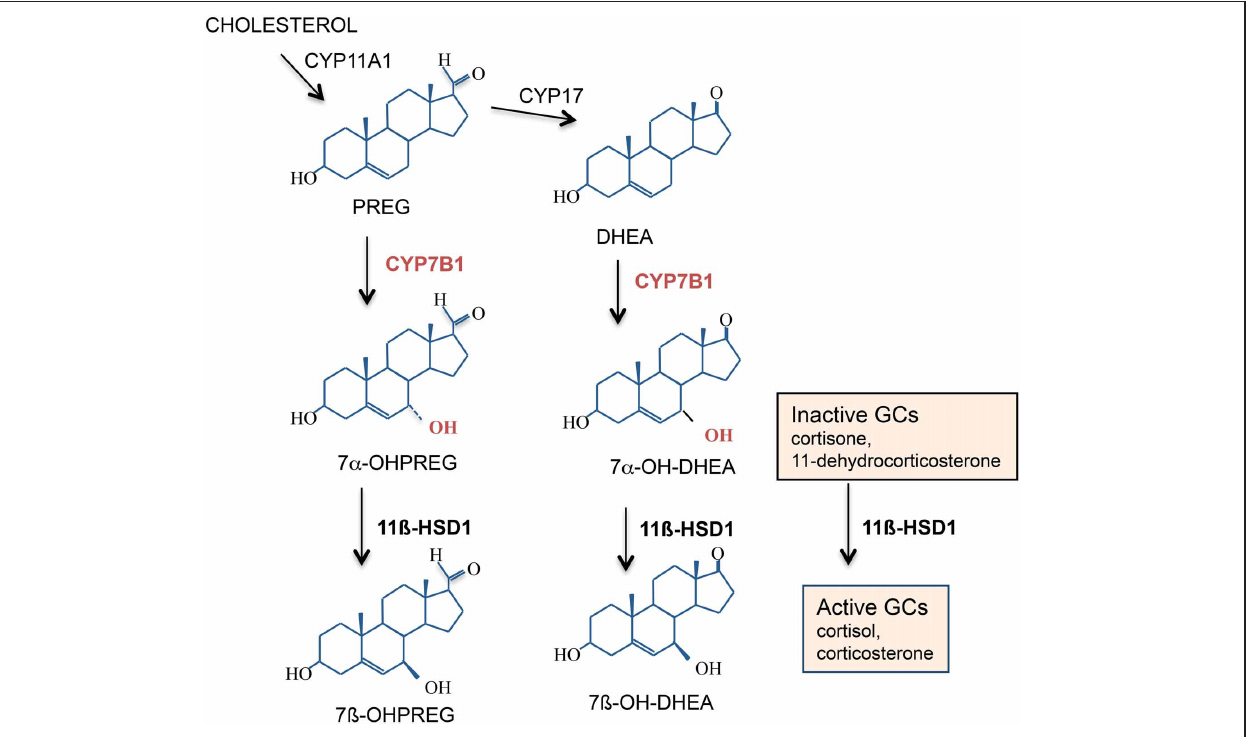
metabolites which are also substrates for 11 β -HSD1. If levels of these 7 α -hydroxylated metabolites within specific cells become high enough, they may compete with the inactive GCs for 11 β -HSD1 and effectively act as endogenous “inhibitors” of 11 β -HSD1 amplification of intracellular GC